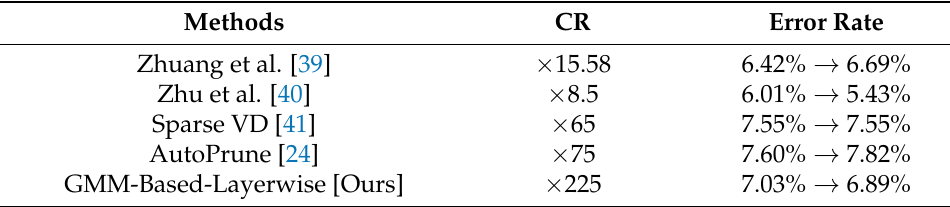
Table 1. Comparison of different unstructured pruning method applying to VGG -16.